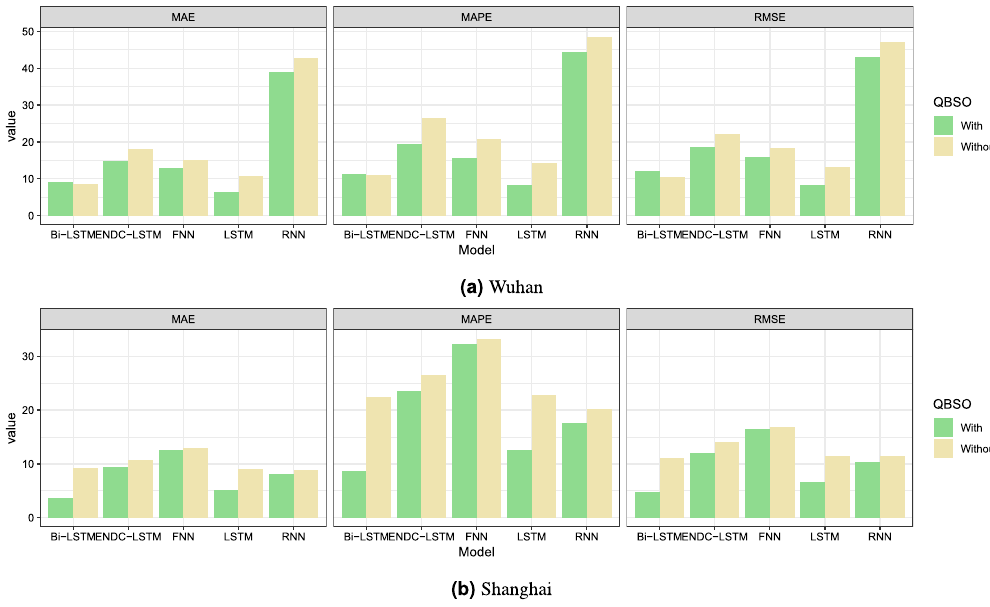
Figure 8. The impacts of QBSO on the different model for t + 1 step prediction.